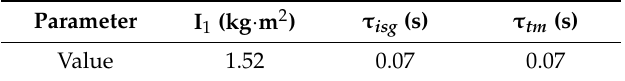
Table 2. Dynamic parameter determination and correction values.